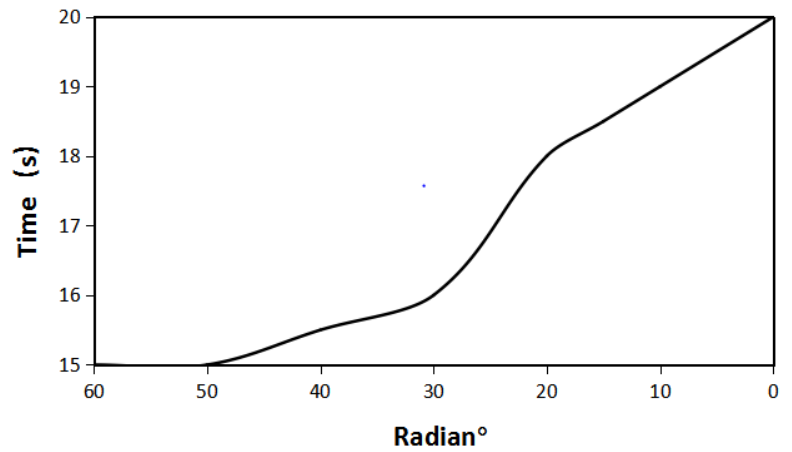
Figure 16. The time required to boost the voltage to 2.8 V under different iron radians.